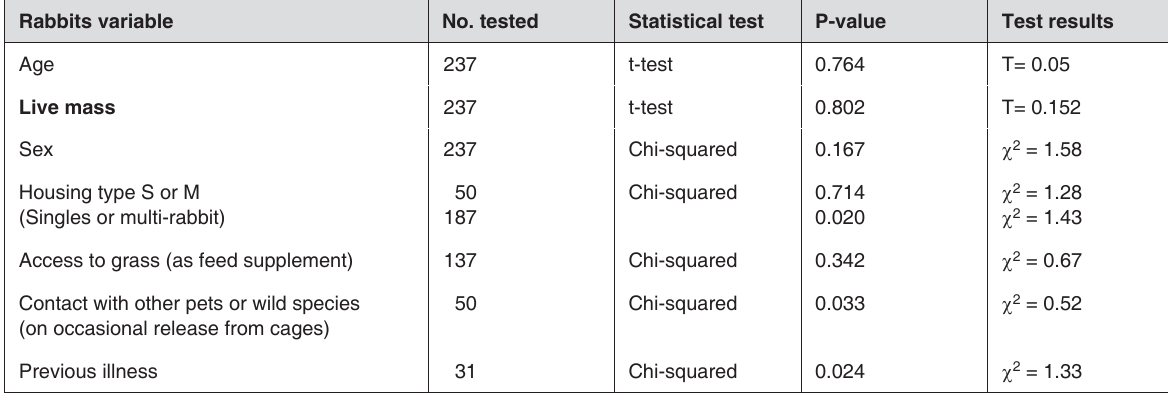
TABLE 2 Statistical analysis of the information returned from the zonal survey of antibodies to E. cuniculi by rabbits in Nigeria Rabbits